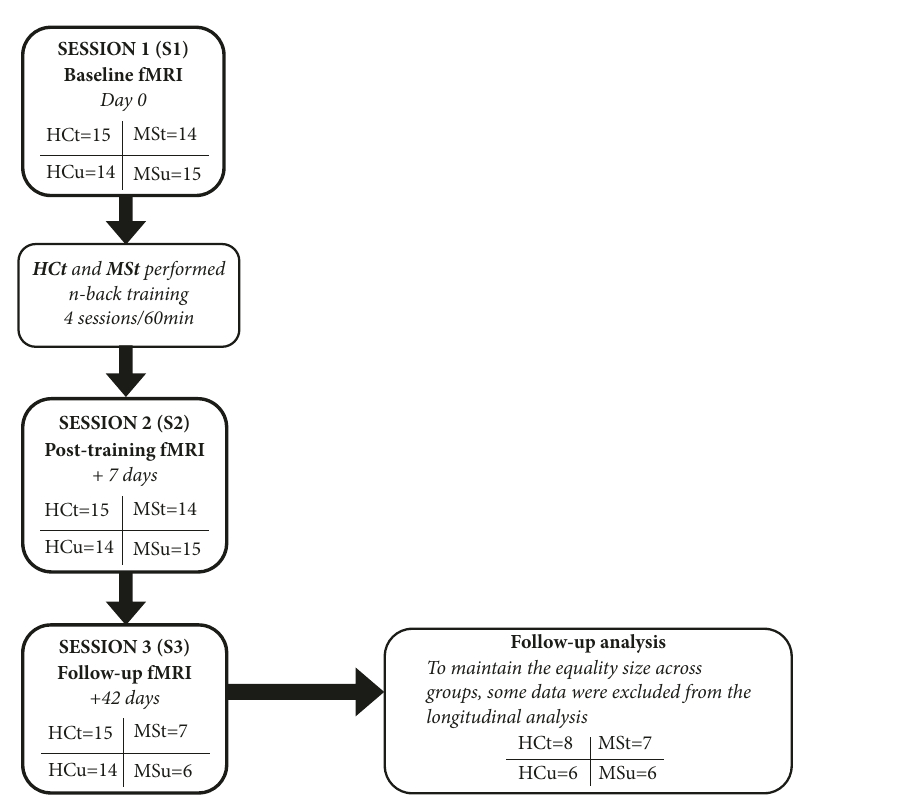
Figure 1: Flow diagram of the phases of the